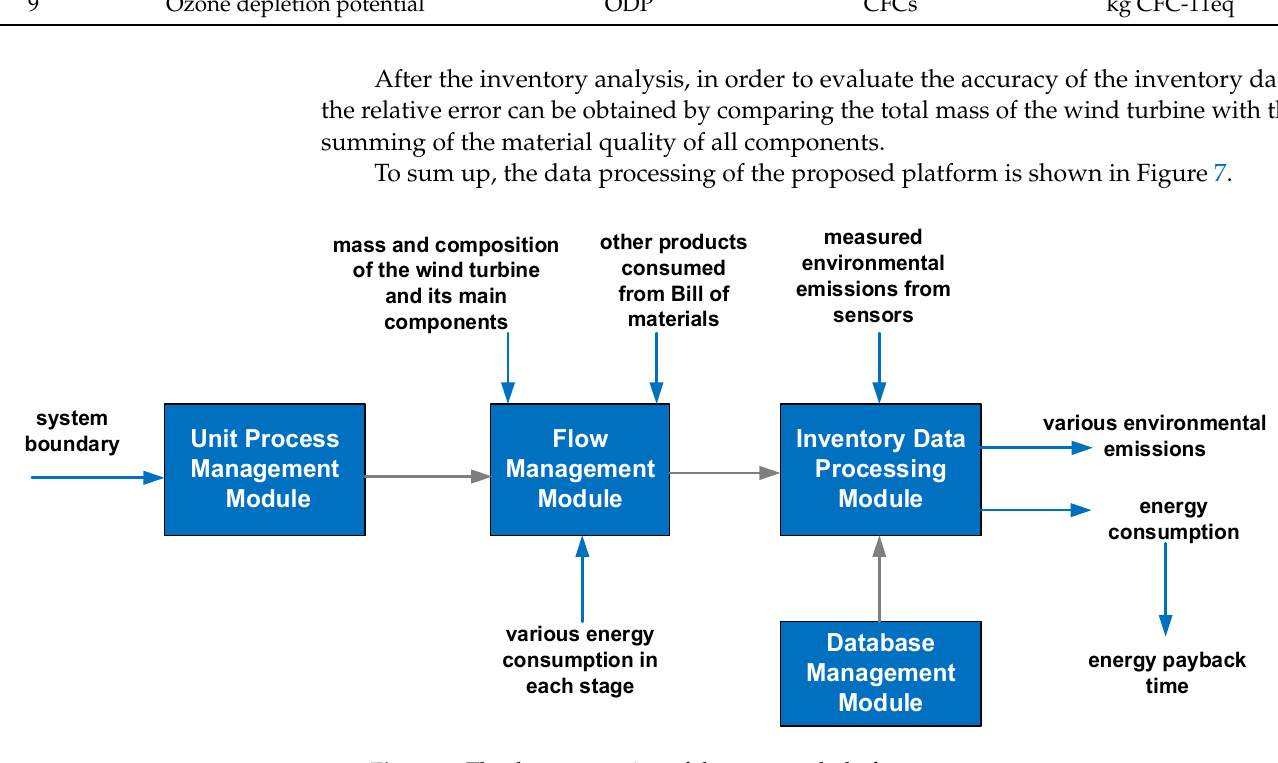
Figure 7. The data processing of the proposed platform.